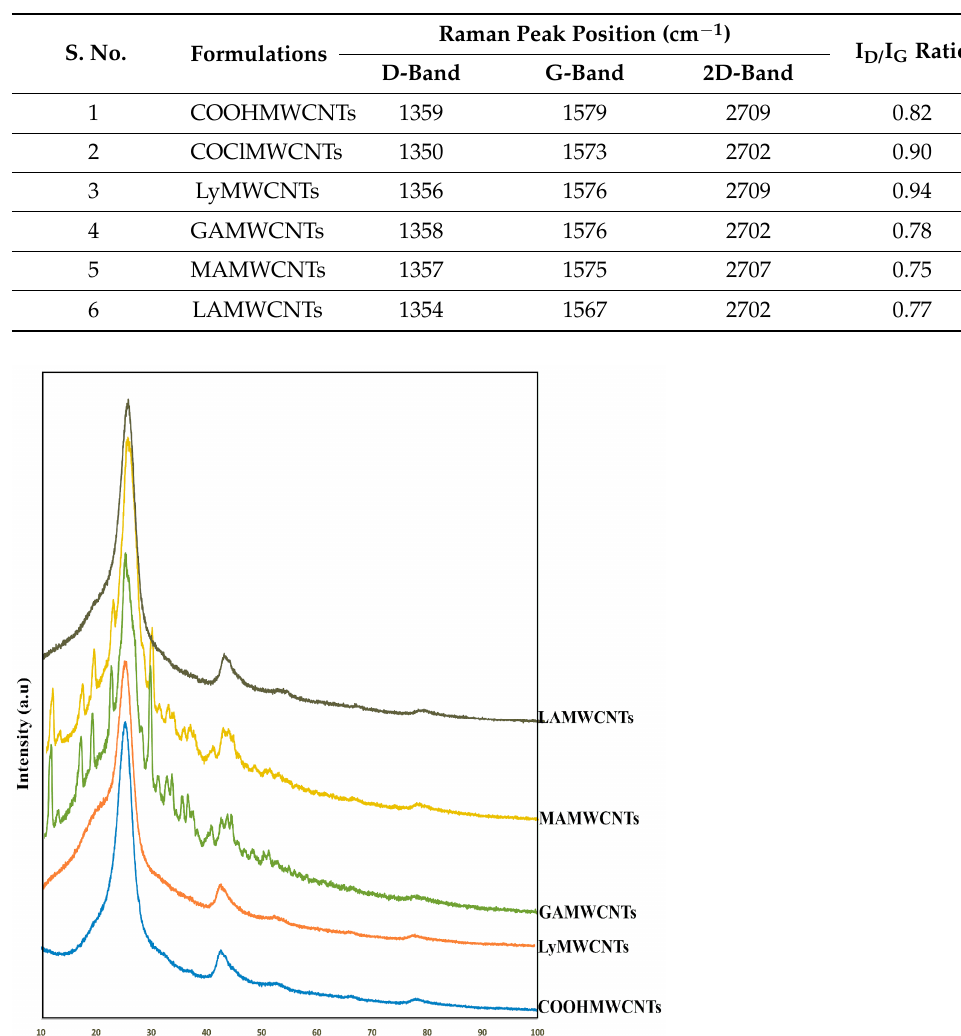
Table 2. Raman spectra of the D-band, G-band and 2D-band wave number (cm − 1 ) and the I D /I G ratio of the formulations.